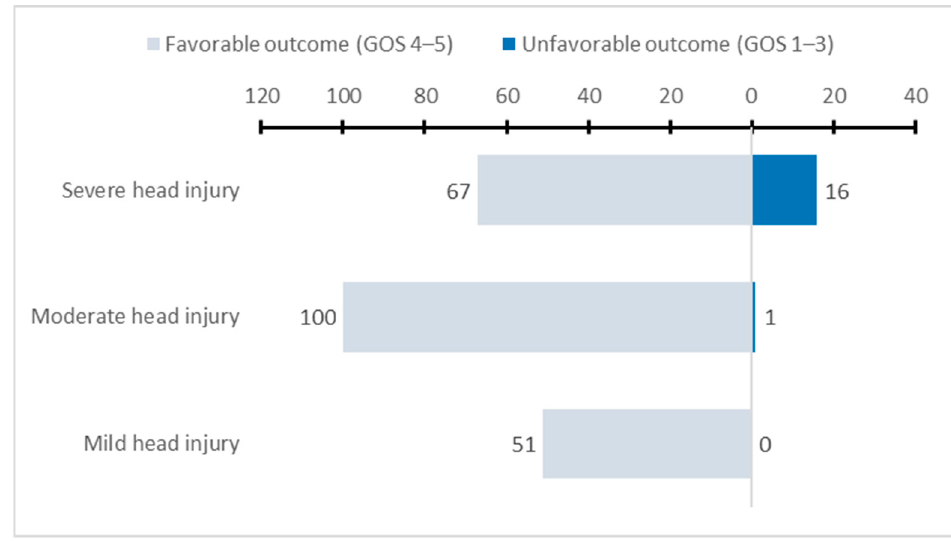
Figure 2. The number of patients with a favorable outcome at three months after injury in the different preoperative GCS groups.